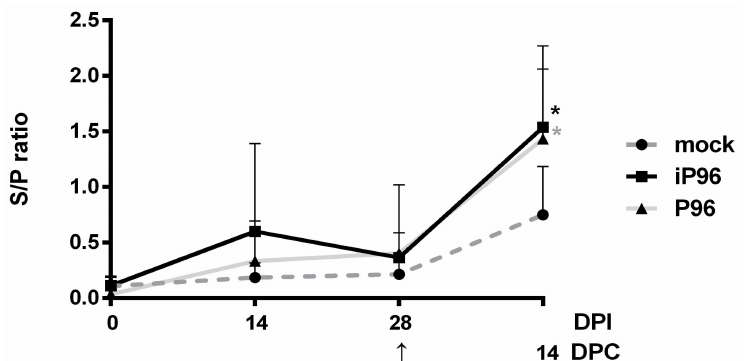
Figure 5. The mean sample-to-positive ratio of the plasma PEDV spike (S)-specific IgG in piglets inoculated with the iPEDVPT-P96 virus ( (cid:4) ), the PEDVPT-P96 virus ( (cid:78) ), or mock-inoculated ( ) at 0, 14, and 28 days post-inoculation (DPI) and at 14 days post-challenge (DPC) after re-challenge or challenge with PEDVPT-P5 virus. Each group consisted of 5 piglets. Data are expressed as the mean ± standard deviation of the sample-to-positive ratio (S/P ratio) in each group generated from optical density (OD) values obtained by an in-house PEDV-Spike based indirect ELISA. The arrow indicated the time point (28 DPI or 0 DPC) of challenge with PEDVPT-P5 virus. Statistically significant differences between each group were examined using two-way ANOVA by time. Significant differences from the mock group are labeled with asterisks ( p <